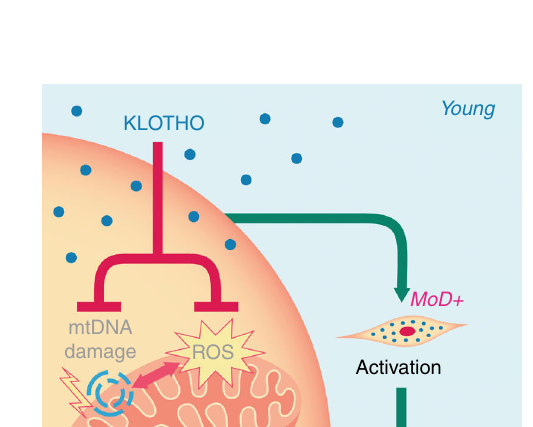
Fig. 6 α -Klotho supplementation improves aged MPC bioenergetics and muscle regeneration. a RT-qPCR-based analysis of mtDNA damage in old and MPCs and in old MPCs that received supplementation with recombinant α -Klotho in the culture medium for 48 h ( n = 3/group; * p < 0.05, one-tailed Student ’ s t test). b , c Seahorse analysis of basal OCR and reserve capacity of age and aged + α -Klotho MPCs ( n = 6 – 8/group; ** p < 0.01). d , e Representative immuno fl uorescent images and quanti fi cation of α -Klotho expression in aged muscle 14 dpi after systemic supplementation of α -Klotho via an osmotic pump, as compared to saline-infused control muscles ( n = 5/group; **** p < 0.0001). Scale: 50 µ m. f Quanti fi cation of the percentage of centrally nucleated fi bers as per histological analysis across saline and α -Klotho infused animals 14 dpi ( n = 3/group; * p < 0.05). g , h Representative SHG imaging and quanti fi cation of the percentage of centrally nucleated fi bers of saline versus α -Klotho infused animals at 14 dpi ( n = 5 – 6/group; * p < 0.05). Scale: 35 µ m. i , j Representative images and quanti fi cation of MyoD + cells at the site of injury 14 dpi in animals receiving osmotic pump delivery of saline or α -Klotho ( n = 5/group; *** p < 0.001). Scale: 25 µ m. k Representative immuno fl uorescent images showing laminin and DAPI in animals receiving i.p. administration of saline, α -Klotho 1 – 3 dpi, and α -Klotho 3 – 5 dpi. Scale: 50 µ m. l Quanti fi cation of percentage of centrally nucleated fi bers in aged animals receiving i.p. administration of saline, α -Klotho 1 – 3 dpi, and α -Klotho 3 – 5 dpi ( n = 4/group; * p < 0.05, ** p < 0.01). m Quanti fi cation of fi ber cross-sectional area across the three i.p. injection groups ( n = 4/group; *** p < 0.001, **** p < 0.0001). n Fold change hang impulse score over baseline scores across the three i.p. injection groups ( n = 6/group). o Force-frequency curves obtained from in situ contractile testing analysis of speci fi c force ( n = 6 – 8/group, * p <